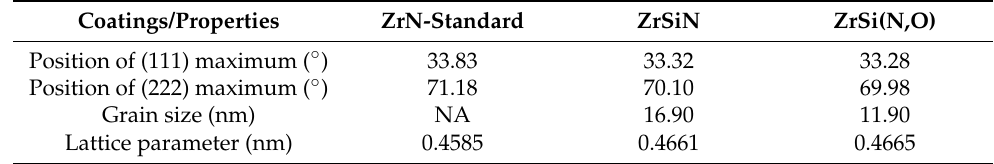
Figure 4. X-ray diffraction patterns of the investigated specimens. Table 1. The standard position of the (111) ZrN maximum (ICDD file #04-004-2860) and the equivalent positions of the peaks measured for ZrSiN and ZrSi(N,O) monolayers, their grain sized, and the calculated lattice parameters.